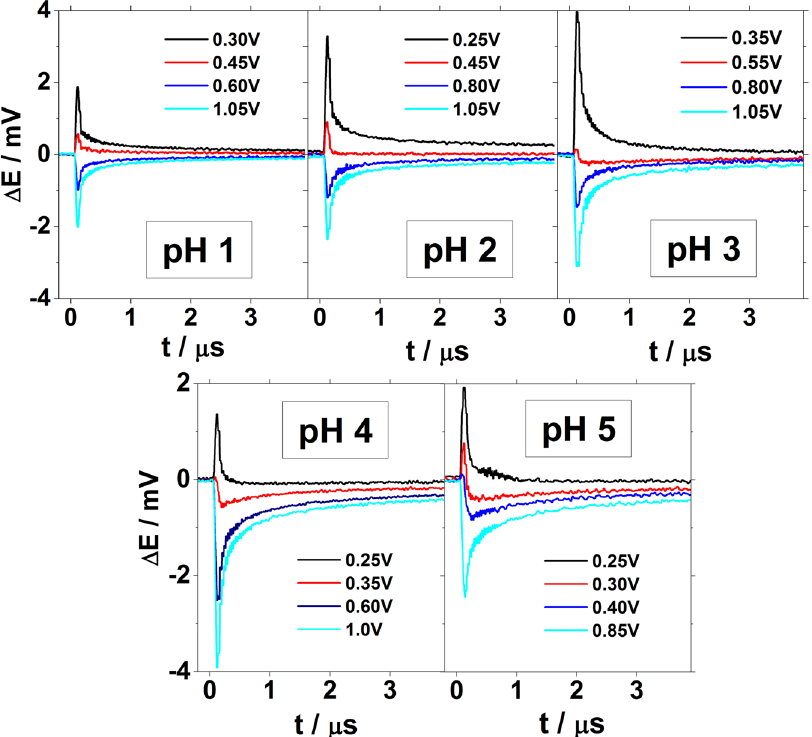
Figure 5. Laser induced potential transients for Ir(111) recorded at the potentials more positive than PME at different pHs. Laser beam energy: 1 mJ. All potentials are given versus the RHE scale. Composition of the electrolytes is the same as in Fig.